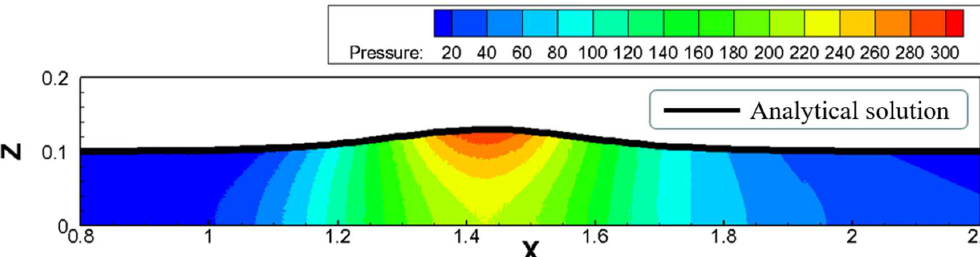
Figure 7. Convergence tests of particle size for the maximum run-up (constant slope angle = 90°).